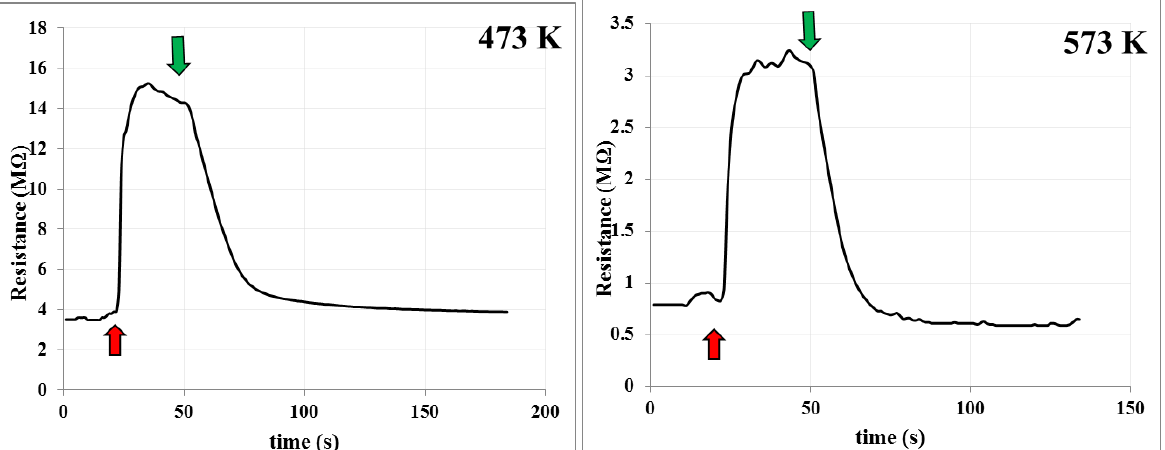
Fig. 7: Variation or resistance of the (SnO) gas at 473 and 573 K.